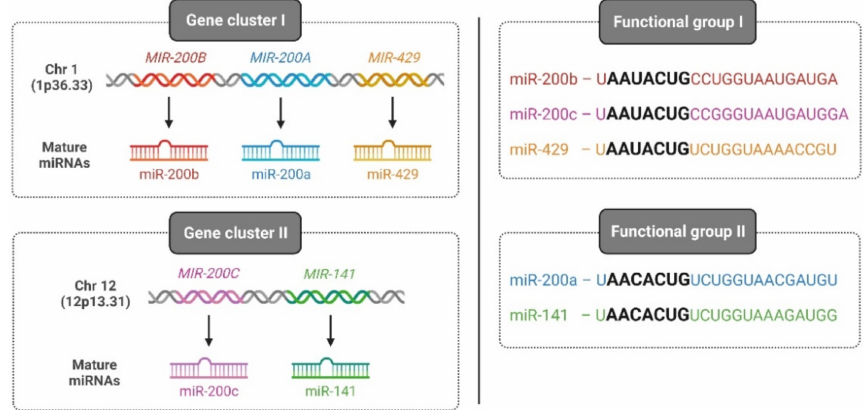
Figure 2. Classification of the human miR-200 family. Two categories of the human miR-200 family classification exist based on the chromosomal location of the gene (left—gene cluster I and II) and based on seed sequences that bind to 3 (cid:48) UTR of cognate genes (right—functional group I and II). Illustration created with Biorender.com (https://biorender.com/, accessed on 1 June 2022). It is also speculated that members of the same miRNA family are segregated in two different locations on the genome, rendering miR-200s with more flexibility in imposing spatial, temporal, and tissue-specific control of target gene expression, since the expression of miR-200s is also subjected to direct regulation through histone modification